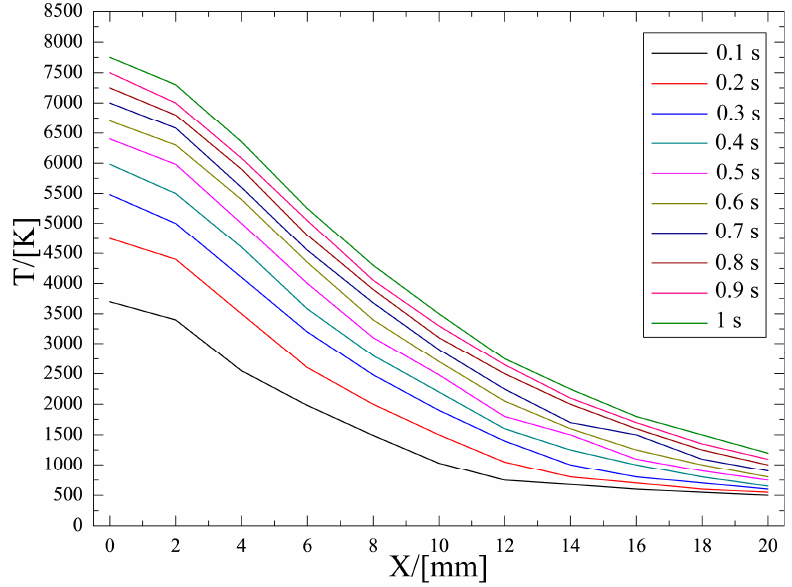
Figure 8. Temperature curve of the upper half-axis of the arc center axis (when gap is 3 mm).